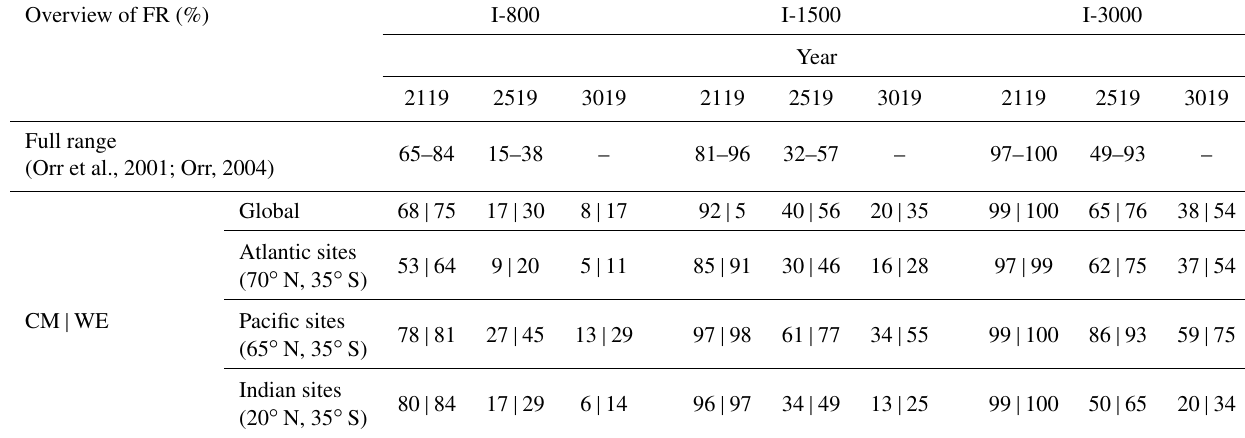
Table 2. Comparison of fractions retained (FR) between Orr et al. (2001), Orr (2004) (full range of their global efficiency, which is the same as the FR defined in Sect. 2.2 and is based on seven ocean general circulation models (OGCMs) and one zonally averaged model result) and our Complete Mitigation (CM) and With Emissions (WE) simulations for all injection sites (Global) and on an inter-basin level for the Atlantic sites (Bay of Biscay, New York, Rio de Janeiro), the Pacific sites (San Francisco, Tokyo) and the Indian sites (Jakarta, Mumbai). The FR values (%) are given for the last year of the injections (2119), 500 years after the simulations started (2519) and for the last year of the simulations (3019). For each entry of the table, numbers to the left of the vertical bars denote results of the CM runs, numbers to the right results of the WE runs. Note that the illustrated years refer to our simulations, ranging from the year 2020 until the year 3020. The GOSAC–OCMIP simulations started in the year 2000 and ended in the year 2500 (Orr et al., 2001). Overview of FR